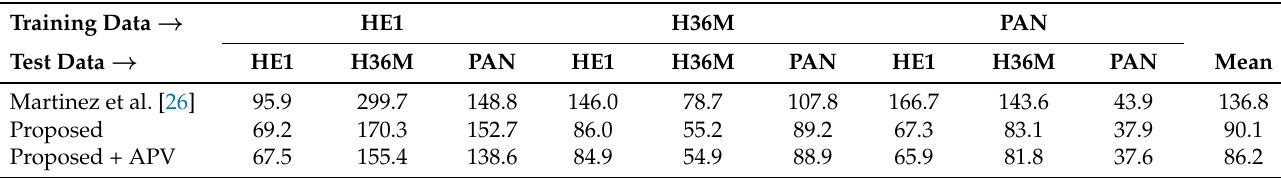
Table 15. No alignment errors of the proposed method compared with Martinez et al. [26]. The proposed method extended Martinez et al. [26] by joint harmonization, scale normalization, some virtual camera augmentation, and, optionally, anatomical pose validation (APV).